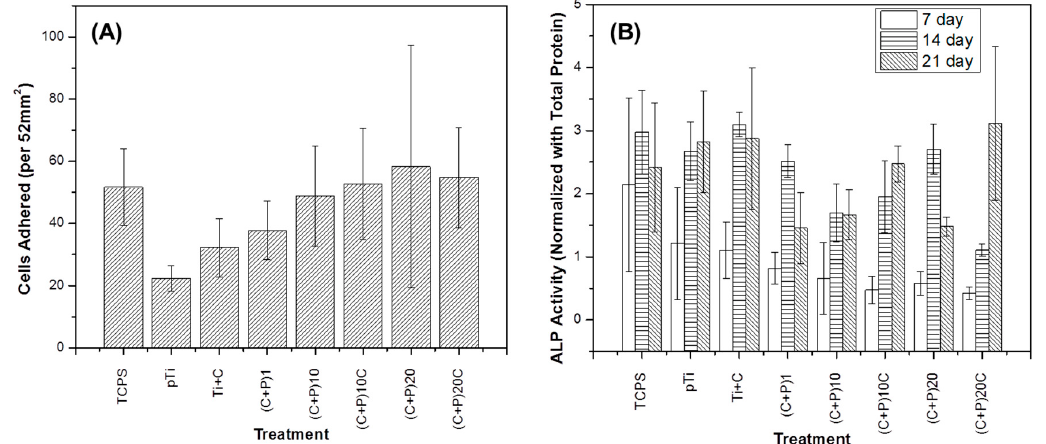
Figure 4. Osteoblast response on LbL surfaces. MC3T3 ( A ) adhesion after 4 h and ( B ) alkaline phosphatase activity after seven, 14, and 21 days of culture on non-coated pTi surface; ( B ) one bi-layered ((C + P) 1 ), 10 bi-layered ((C + P) 10 ), 20 bi-layered surfaces ((C + P) 20 ), and an additional layer of chitosan for the different layered surfaces (Ti + C, (C + P) 10 C, and (C + P) 20 C). Alkaline Phosphatase (ALP) activity is an early osteoblast differentiation marker. As seen in